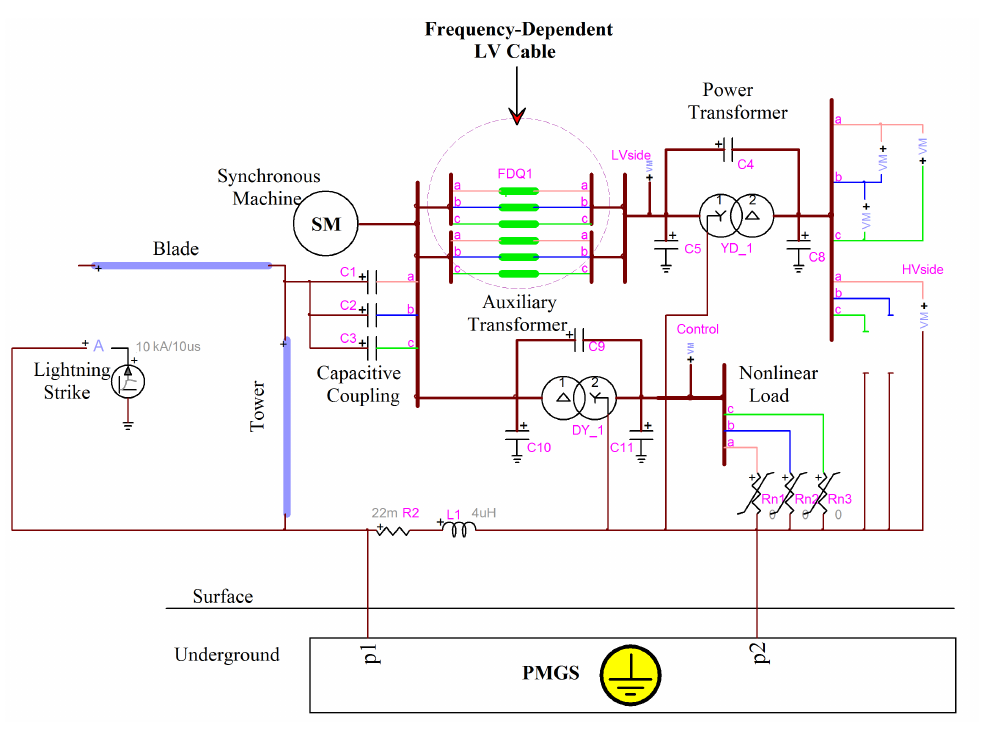
Figure 7. Circuit of the simulated wind turbine with dependent